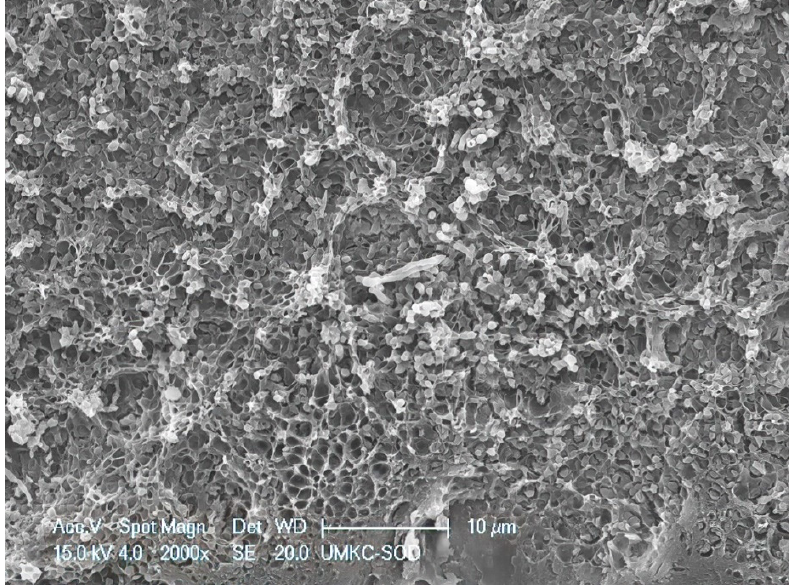
Figure 8. Area of residual biofilm following treatment with SRP + EDTA. Note the honeycomb appearance of the EPM indicating loss of structural integrity and loss of embedded microbes. Original magnification of 2000×; Bar = 10 μ m.